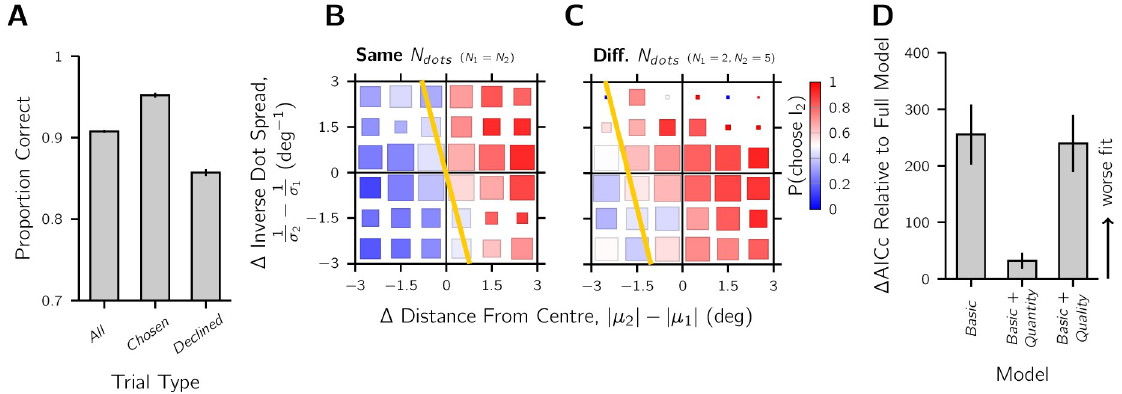
Fig 3. Confidence manipulation checks. A) Suprathreshold Type 1 task performance. The mean proportion of correct spatial judgements across observers is shown for different trial categories. The left-most bar shows performance for all trials, and the next two bars for trials sorted by confidence, either being in the interval chosen as more confident or declined. B-C) Raw confidence choices, sorted by stimulus properties across the two intervals of a confidence pair. The colour code represents the proportion of “Interval 2” as more confident choices averaged across observers. Confidence choices are plotted as a function of the difference in distance from centre across intervals and difference in inverse dot spread. The distance from centre and dot spread were calculated using the empirical mean and SD of the dots displayed, and binned in the range ± 3˚ for plotting. Gold line: the confidence-indifference contour, where the observer is equally likely to report Interval 1 or 2, calculated from the Full model in the nested logistic regression analysis. B) Comparisons where the number of dots was the same in each interval. C) Comparisons where the number of dots differed, with stimulus information and confidence selectively flipped so that Interval 2 has more dots for plotting purposes. D) Model comparison for the nested logistic regression analysis. AICc scores are reported relative to the Full model (winner) that contained both quantity and quality predictors. The Basic + Quantity and Basic + Quality models only contained one of these predictors and the Basic model contained neither. The results show that both the quantity and quality manipulations affected confidence. Larger positive scores indicate a worse fit. Error bars: ±